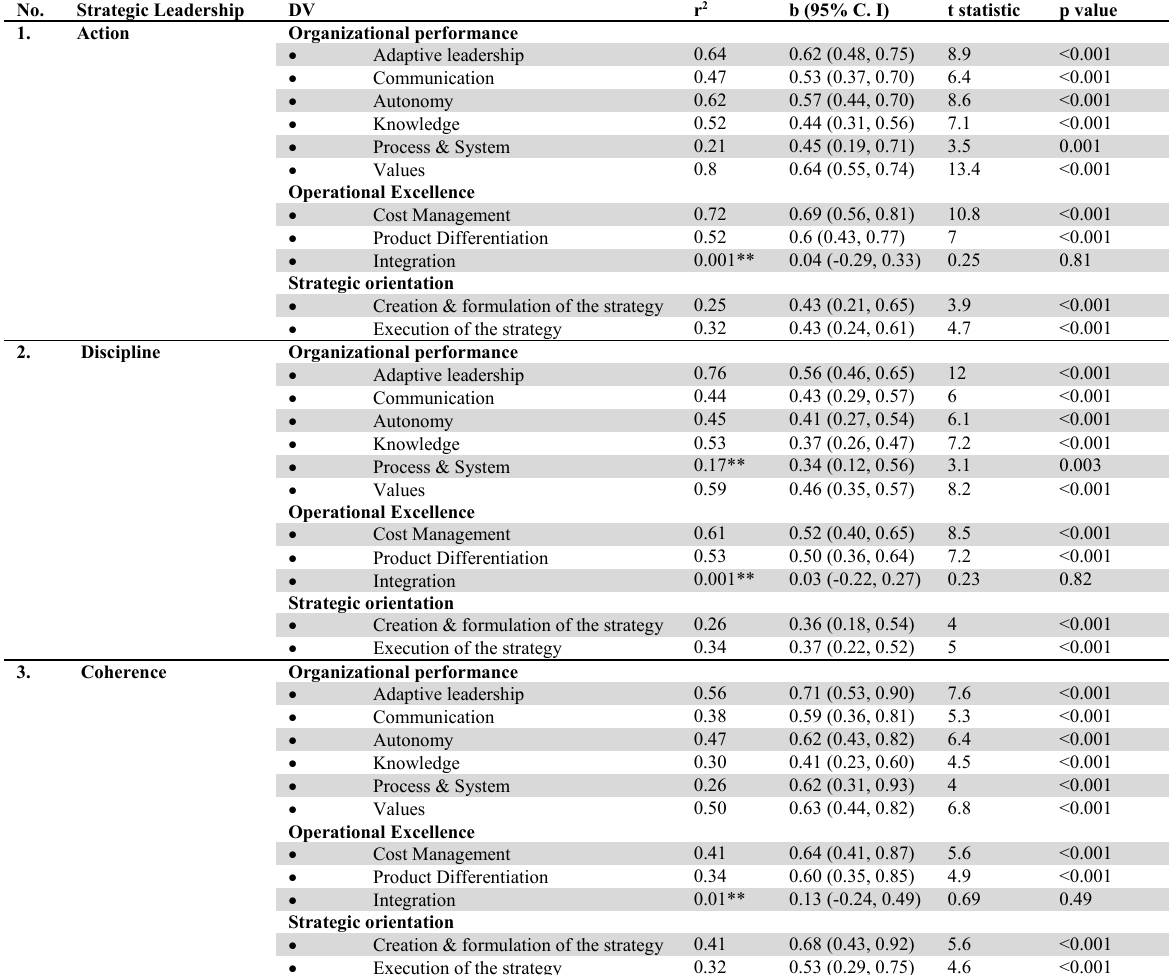
Effect of Strategic Leadership on strategic leadership on the operational strategy, organisational perfor- mance and strategic orientation in Proton (n=48) No. Strategic